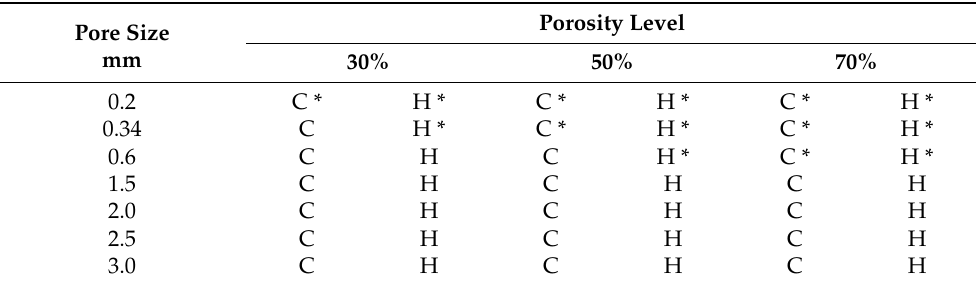
Table 1. Scaffold geometries designed for cubic and hexagonal closed packed structures (C, cubic structures; H, hexagonal closed packed structures; geometries marked with * indicate the samples could not be printed due to smaller strut